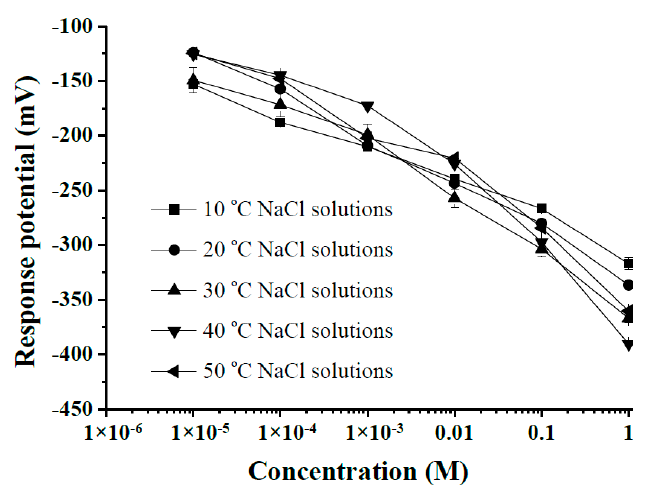
Figure 7. The response potentials of the arrayed flexible RuO 2 /GO chloride sensor at different NaCl solution temperatures from 10 °C to 50 °C.